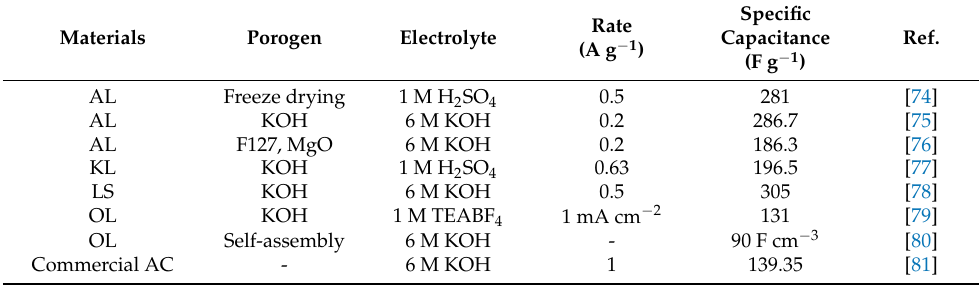
Table 4. Specific capacity values of electrodes for EDLCs based on